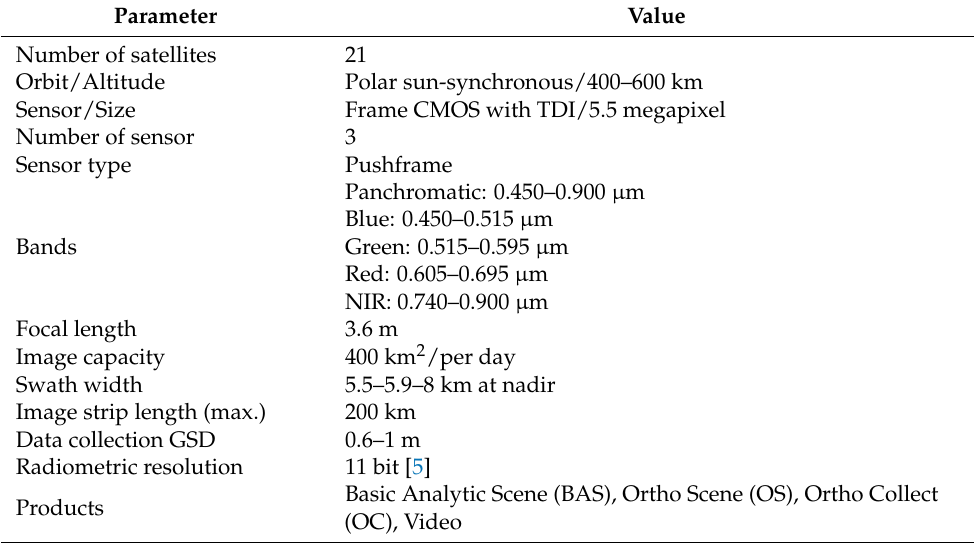
Table 1. The main characteristics of the SkySat constellation and the sensors [5,29]. Parameter